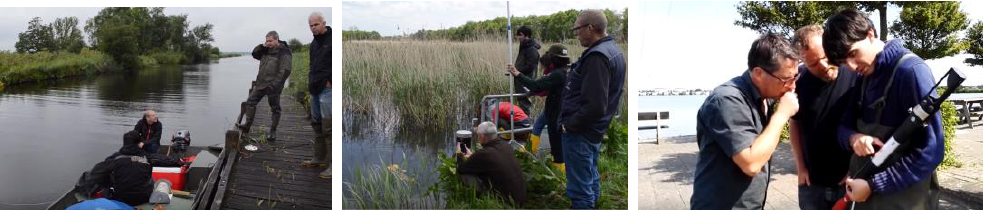
Figure 3. Impression of the field monitoring, often with the participation of water managers.